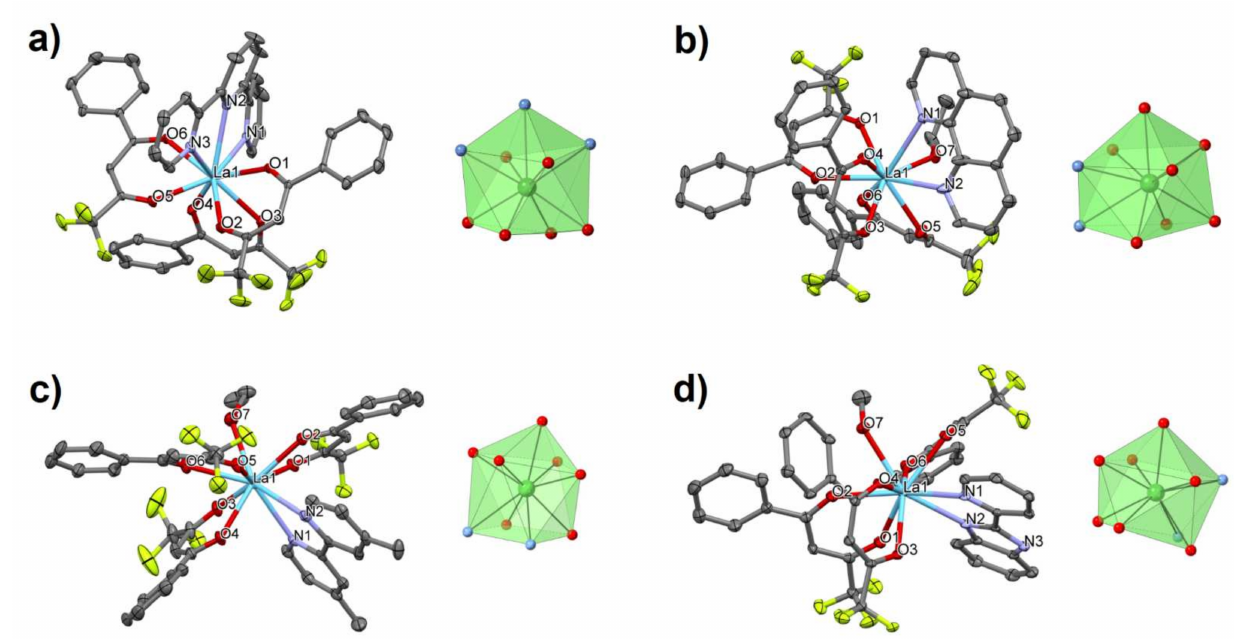
Figure 2. ( a – d ) Perspective view and coordination figure of 5–8 ,